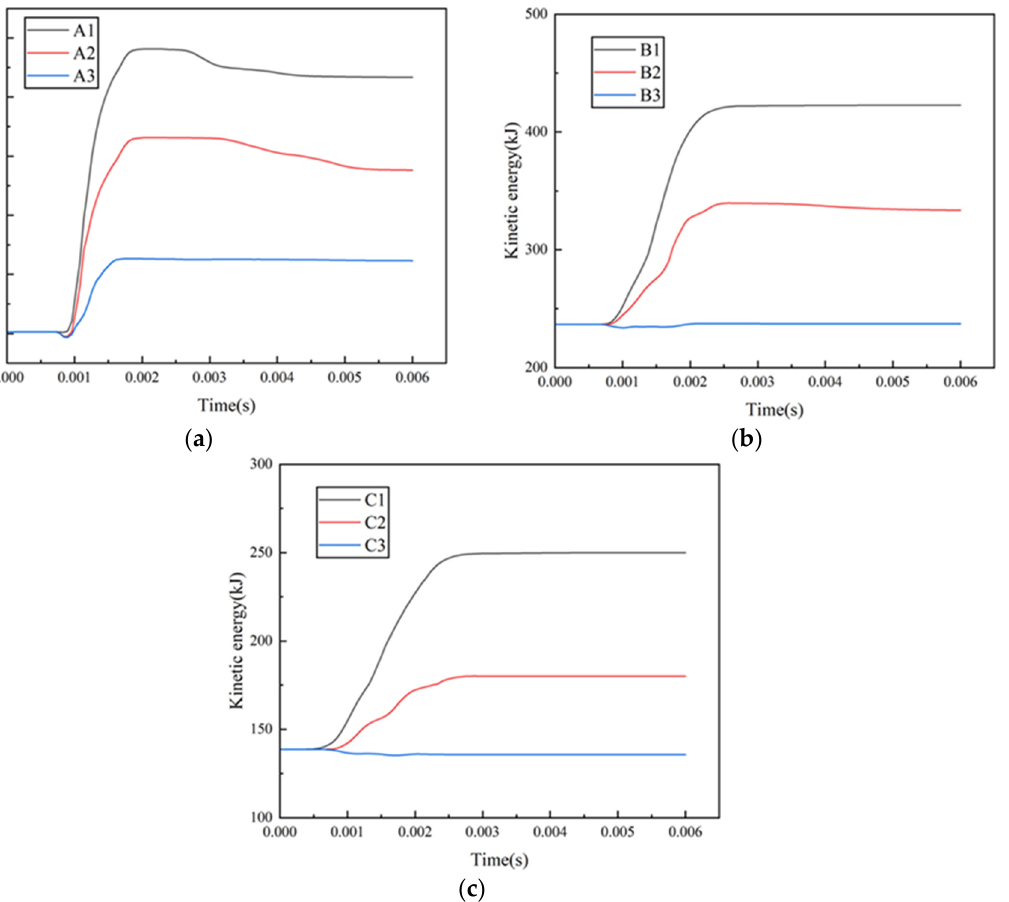
Figure 9. Kinetic energy vs. time: ( a ) small flocking birds; ( b ) medium flocking birds; ( c ) large single bird.